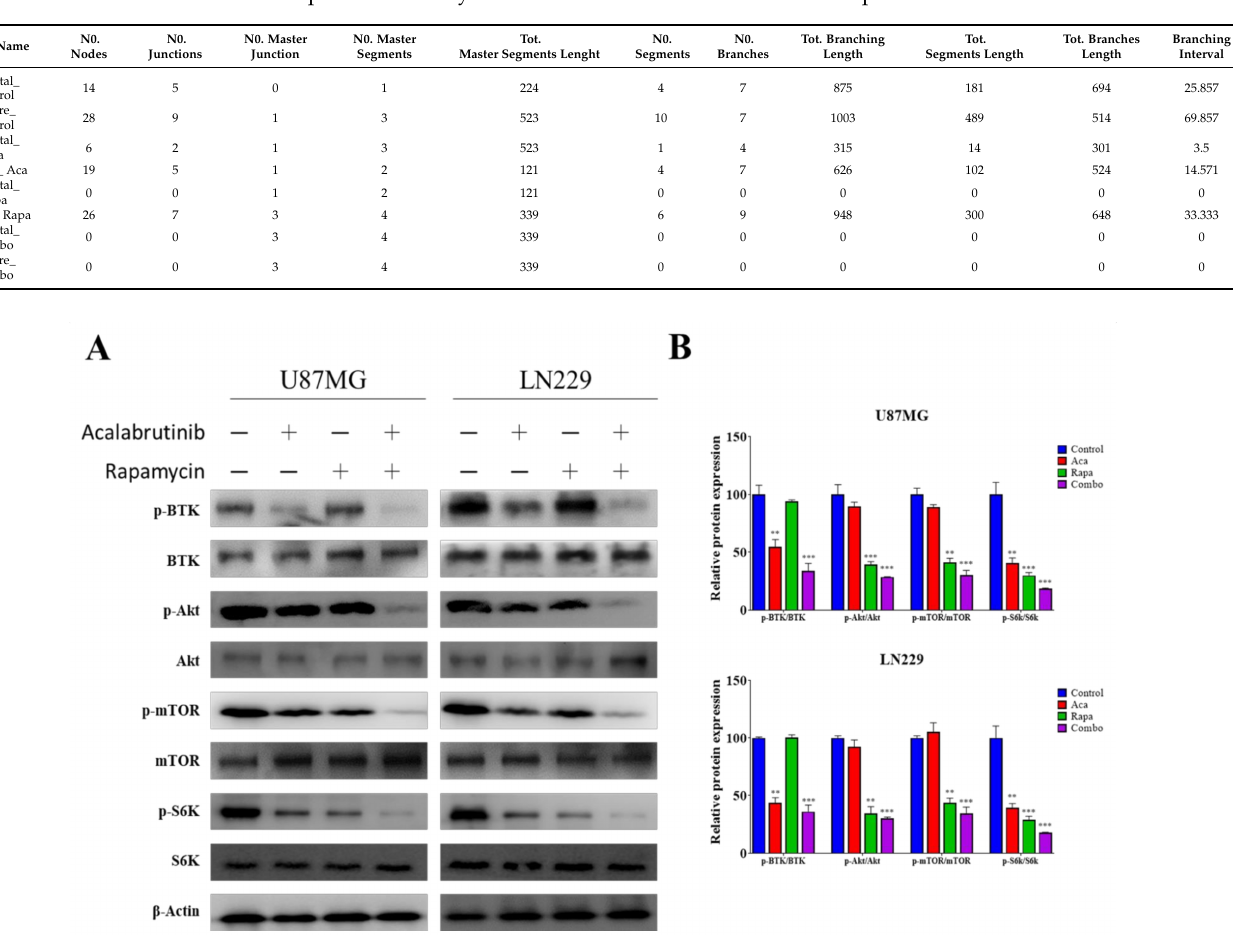
Table 1. Computational analysis of HUVEC tube formation based on phase contrast.